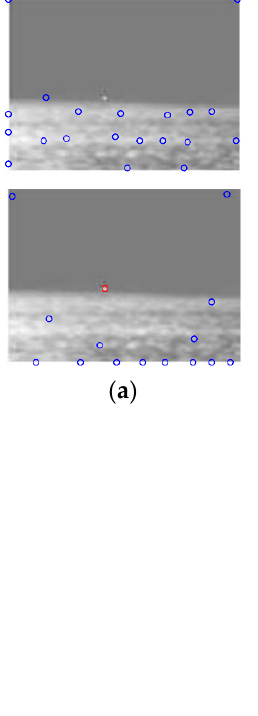
Figure 10. The detection results of the proposed method and DPS-GVR. ( a – d ) Four images selected from Seq.1 with high-brightness background clutter around the target. The first row shows the re- Figure 11. ROC curves and AUC values. ( a – d ) ROC curves and AUC values of the 8 methods for sult of DPS-GVR and the second row shows the result of the proposed method. sequence 1–4.